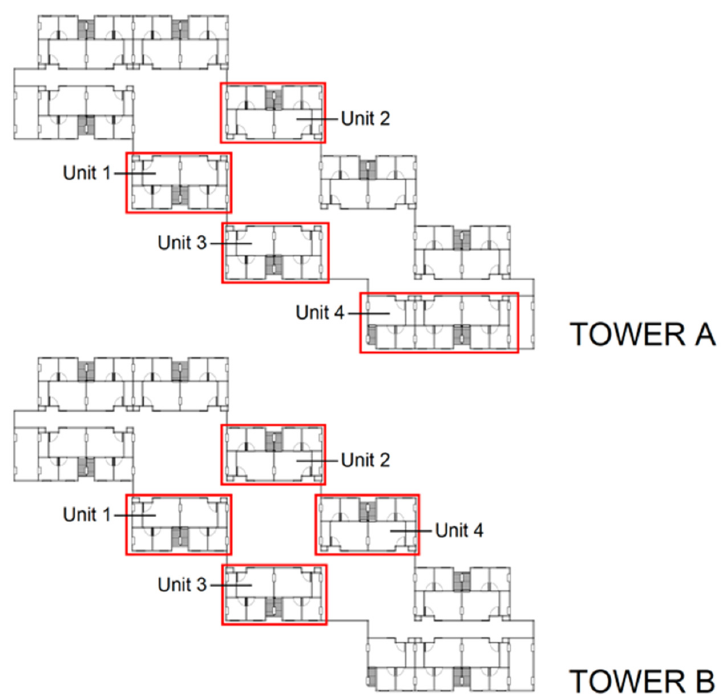
Figure 10. Residential unit numbers in the simulation.